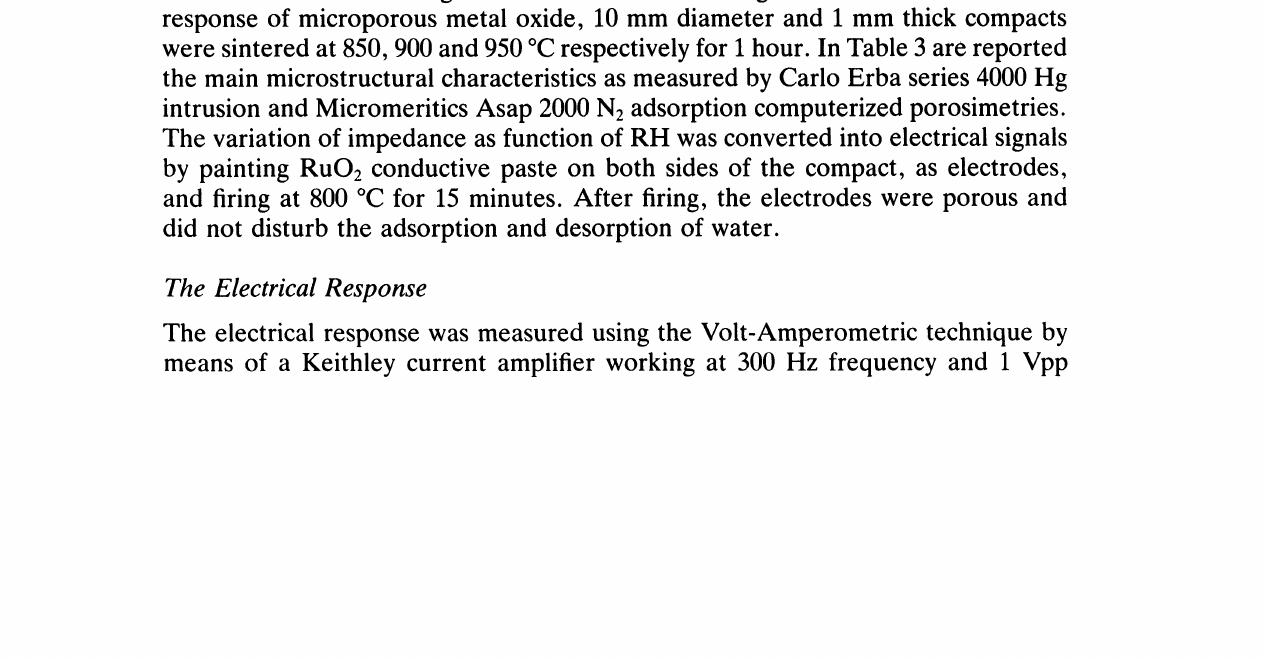
FIGURE 3 N2 adsorption pore size